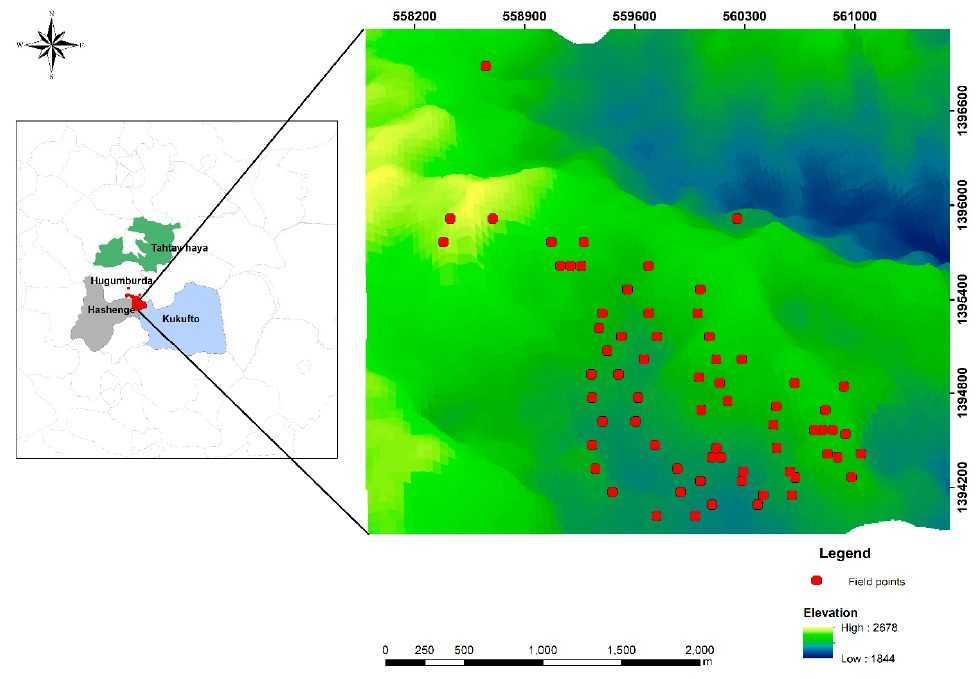
Figure 1. The sample plots in Hugumburda Forest in relation to the study villages, Hashenge, Kukufto, and Tahtay Haya.